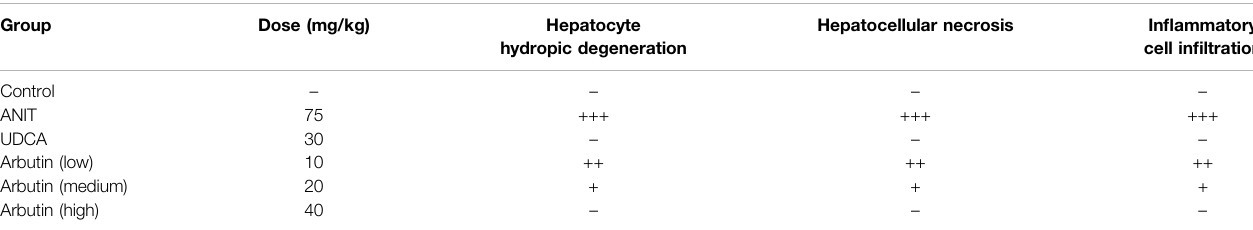
TABLE 3| Effect ofarbutinonmorphologicalchangesoftheliverafterANIT treatment. Dataareexpressed asthemeanofsixspecimensforeach group. − ,negative;+,mild ( < 10 cells). Group Dose (mg/kg) Hepatocyte